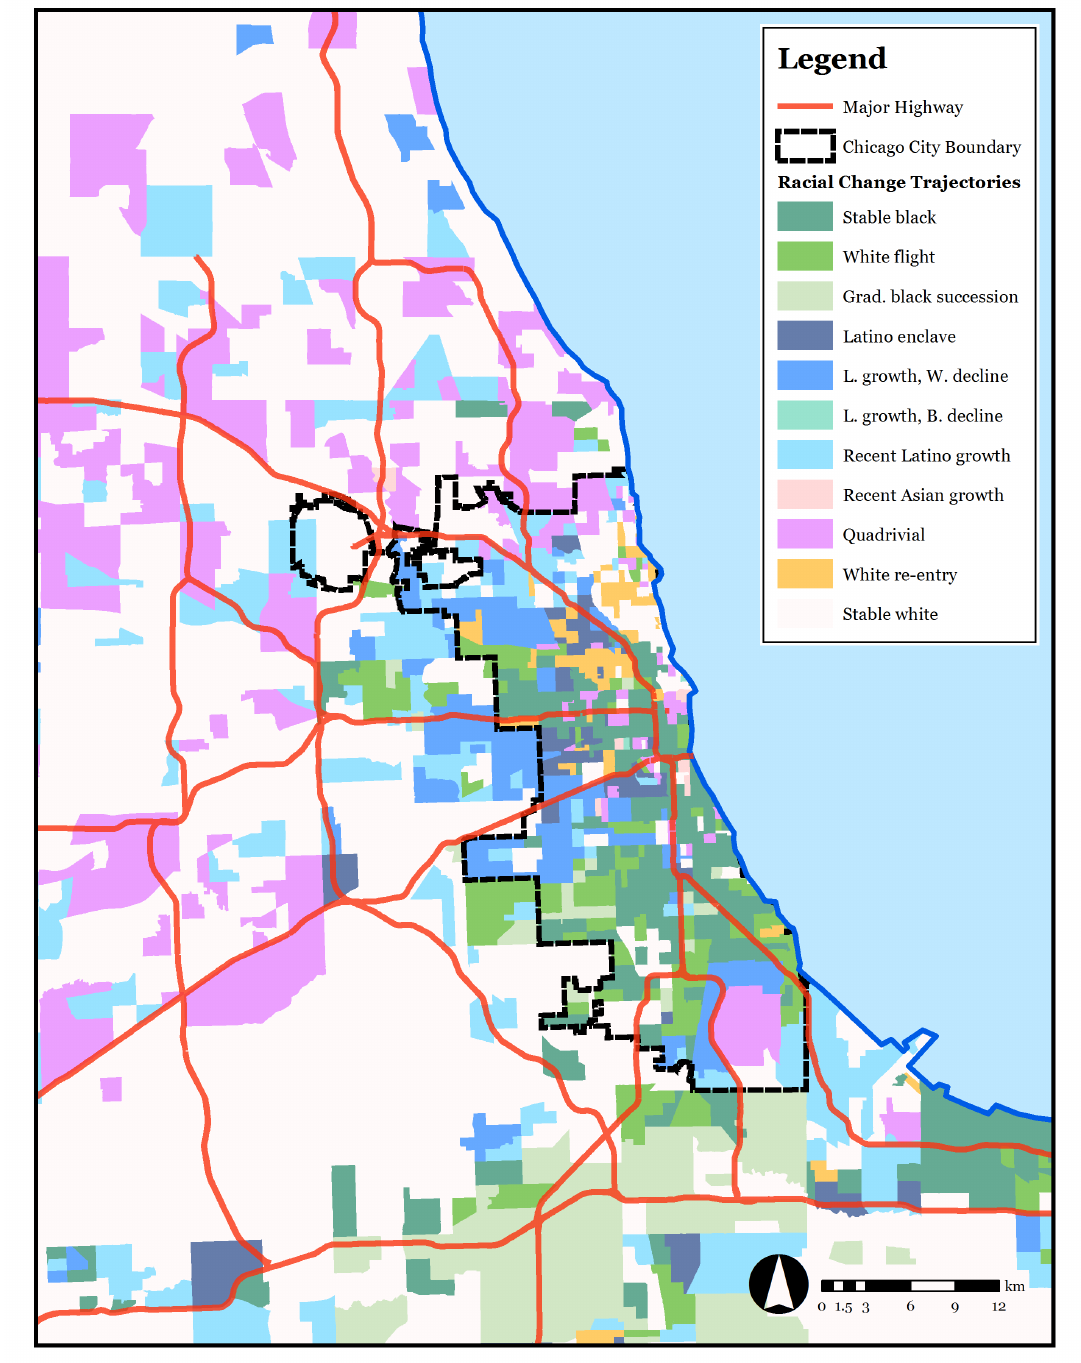
Figure 5: Map of neighborhood racial change trajectories from 1970–2010 in the Chicago metropolitan area (map shows a detail of neighborhoods in and near Chicago; a map of the complete CMSA is available upon